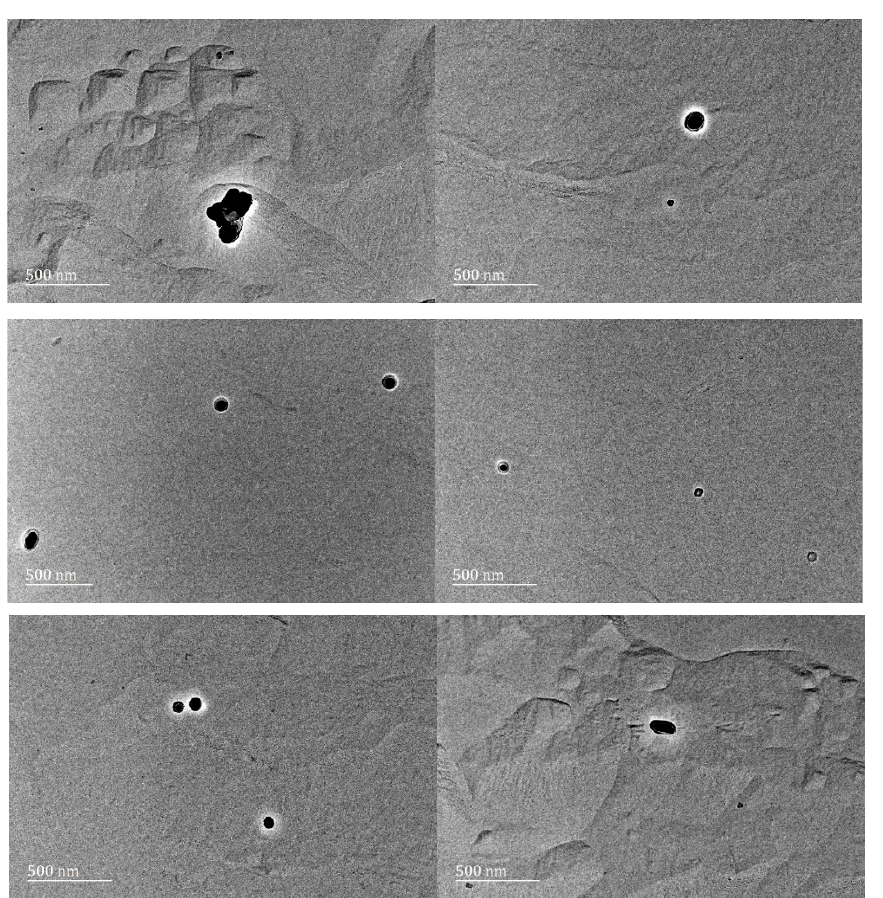
Figure 14. TEM morphology of micro inclusions in hot-rolled sheet, after rare earth treatment.